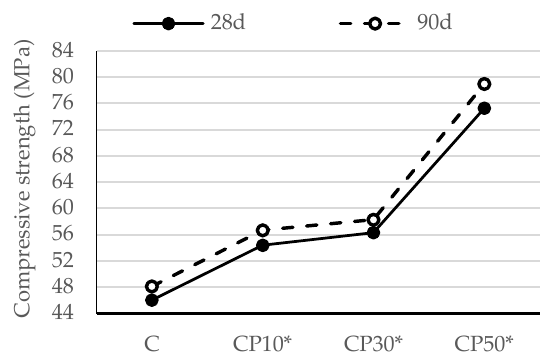
Figure 15. Compressive strength of mortars blended with ceramic powder, with decreased w/b.